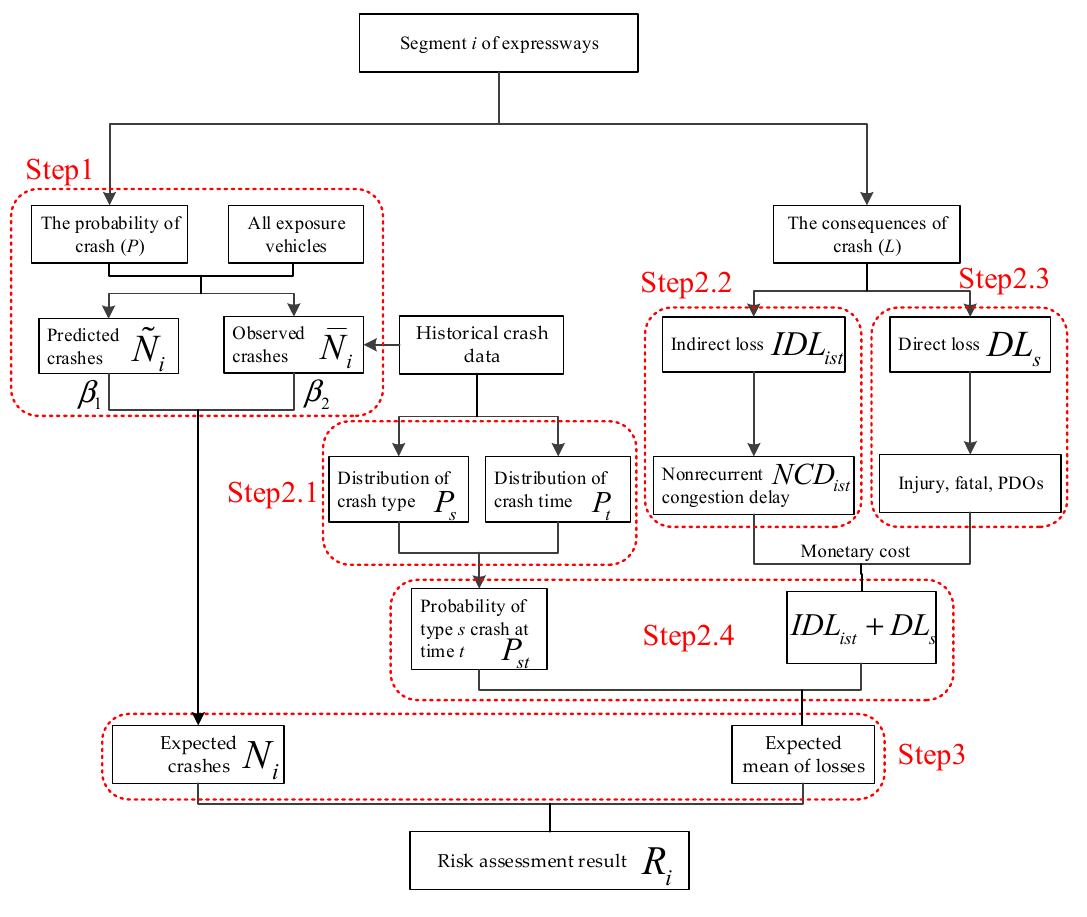
Figure 3. The flowchart of crash risk assessment model.